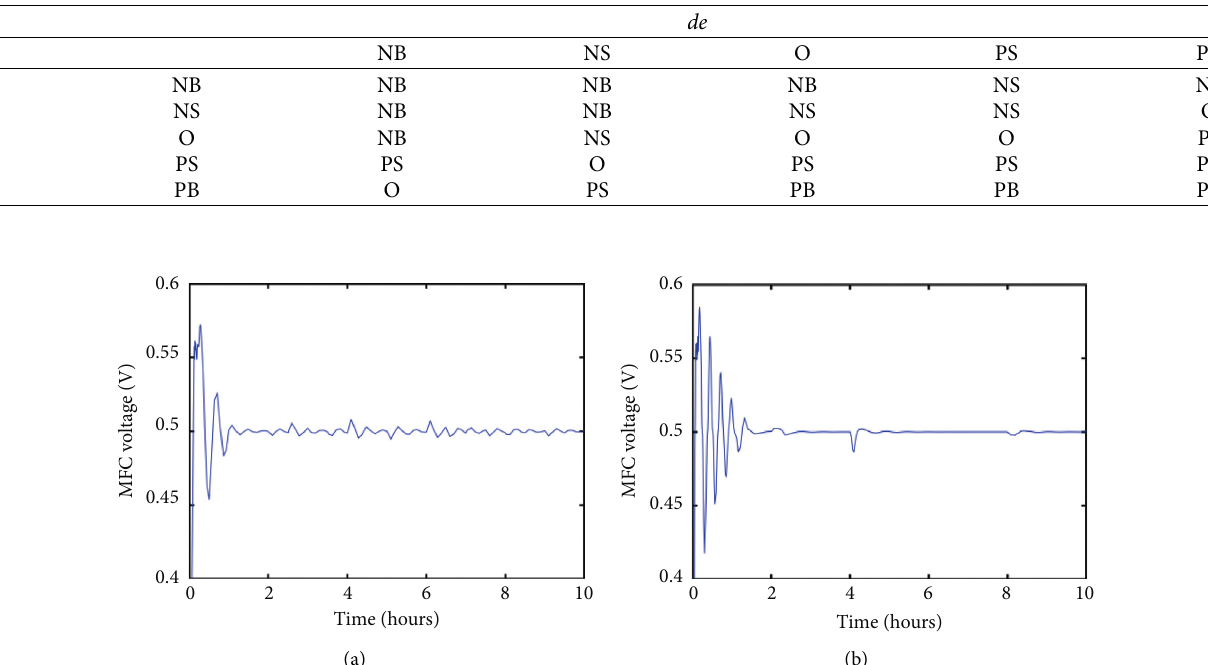
Figure 2: Block diagram of fuzzy integral sliding mode control. Table 1: Fuzzy control rule.